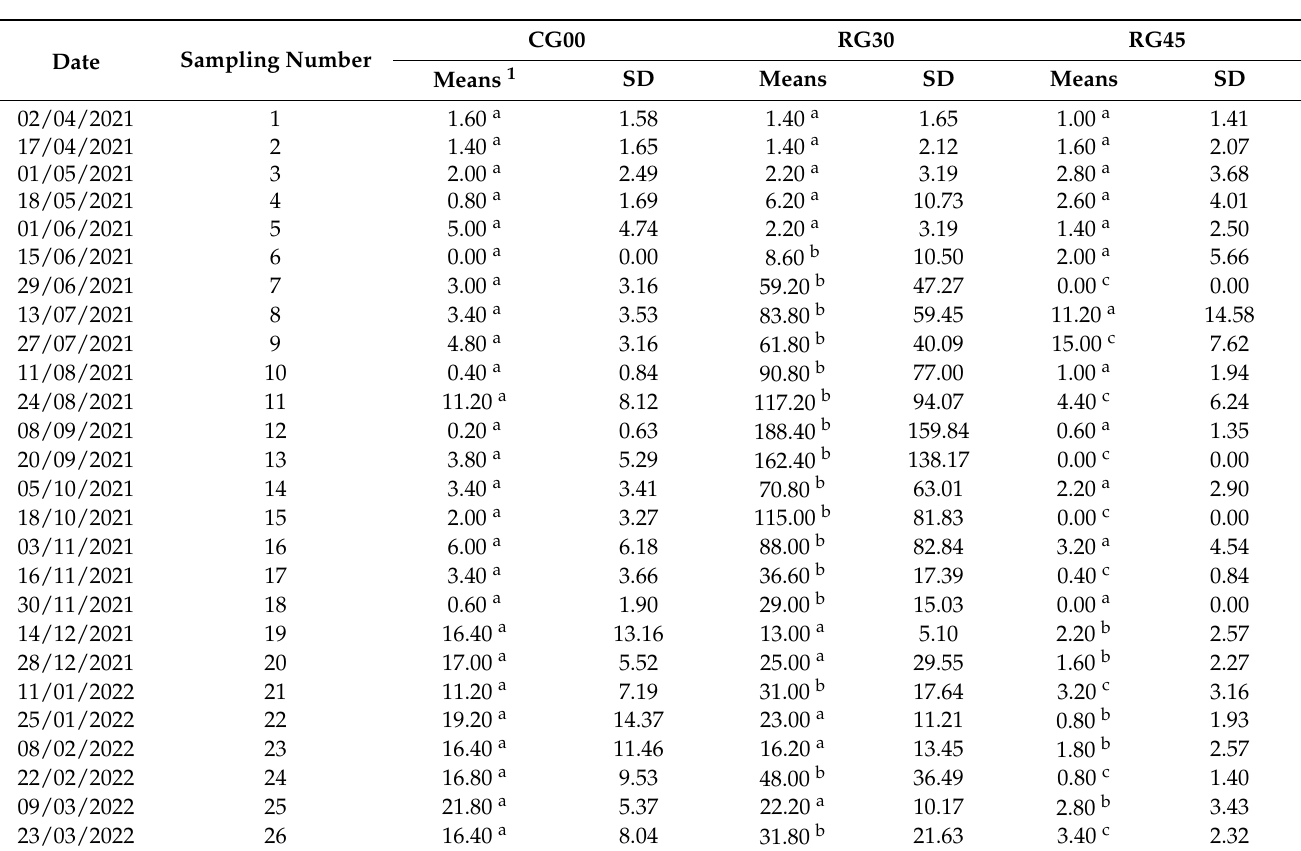
Table 1. Number of Rhipicephalus microplus in cattle (>4.5 mm) under three grazing systems over a